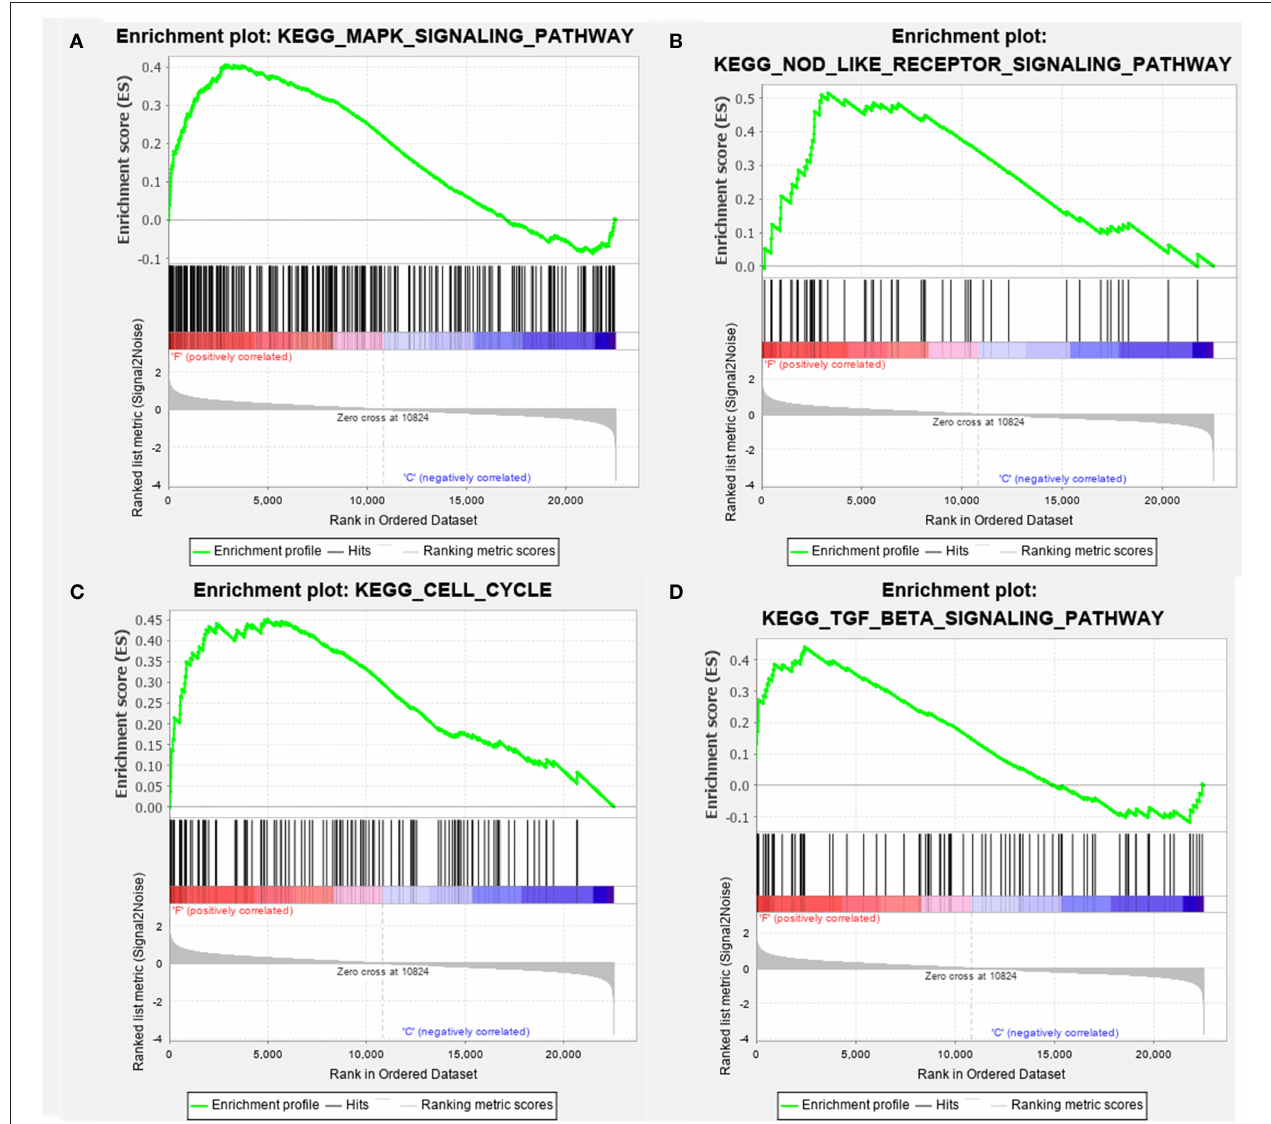
FIGURE 3 | The enriched signaling pathway through the gene set enrichment analysis (GSEA). (A) MAPK signaling pathway, (B) NOD-like signaling pathway, (C) Cell Cycle, and (D) TGF-beta signaling pathway. The gene set c2 (cp.kegg.v.6.2.symbols.gmt) database was used to analyze the whole gene expression value of the AV fistula and control samples. The cutoff criteria of the significant gene set were the absolute value of normalized enrichment score (NES) > 1, nominal P < 0.05, and FDR < 0.25. The enrichment plots (A–D) illustrate the high expression of the four gens set in the AV fistula group. F, AV fistula; C,